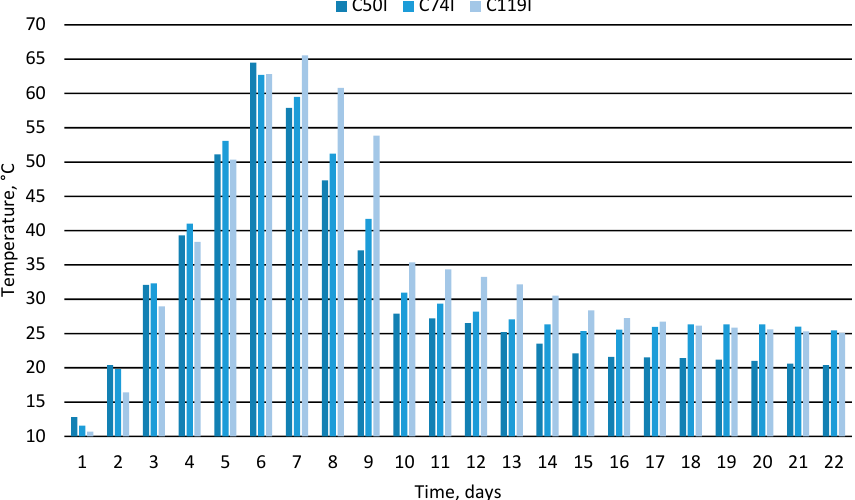
Figure 2. Change of composted material temperature over